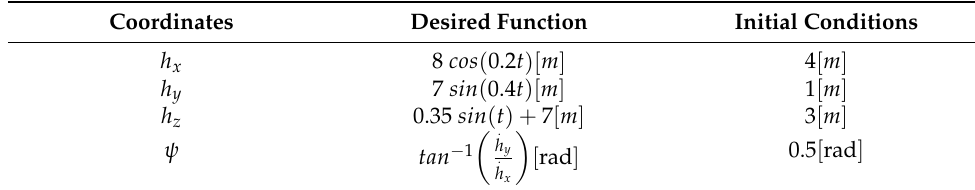
Table 1. Desired references for the